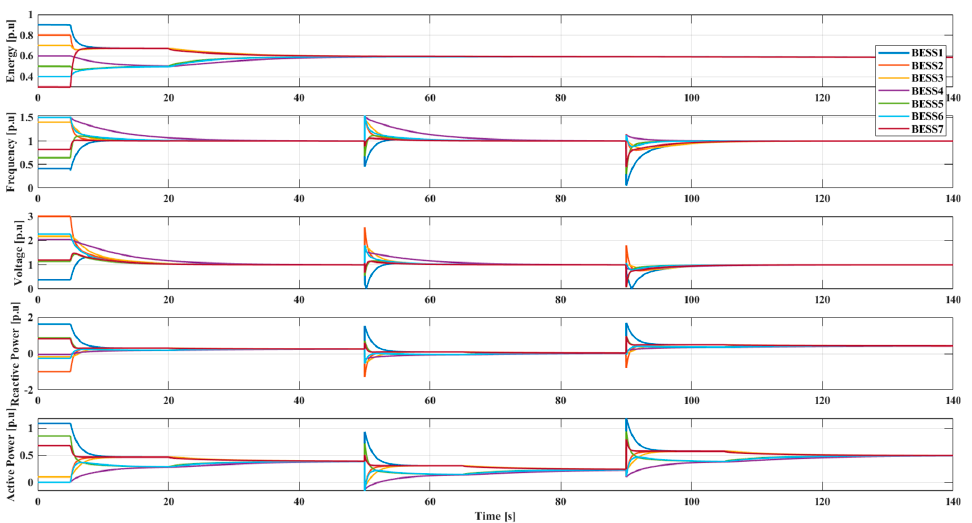
Figure 8. Simulation results of step-by-step consensus algorithm with the virtual leader (case 4).